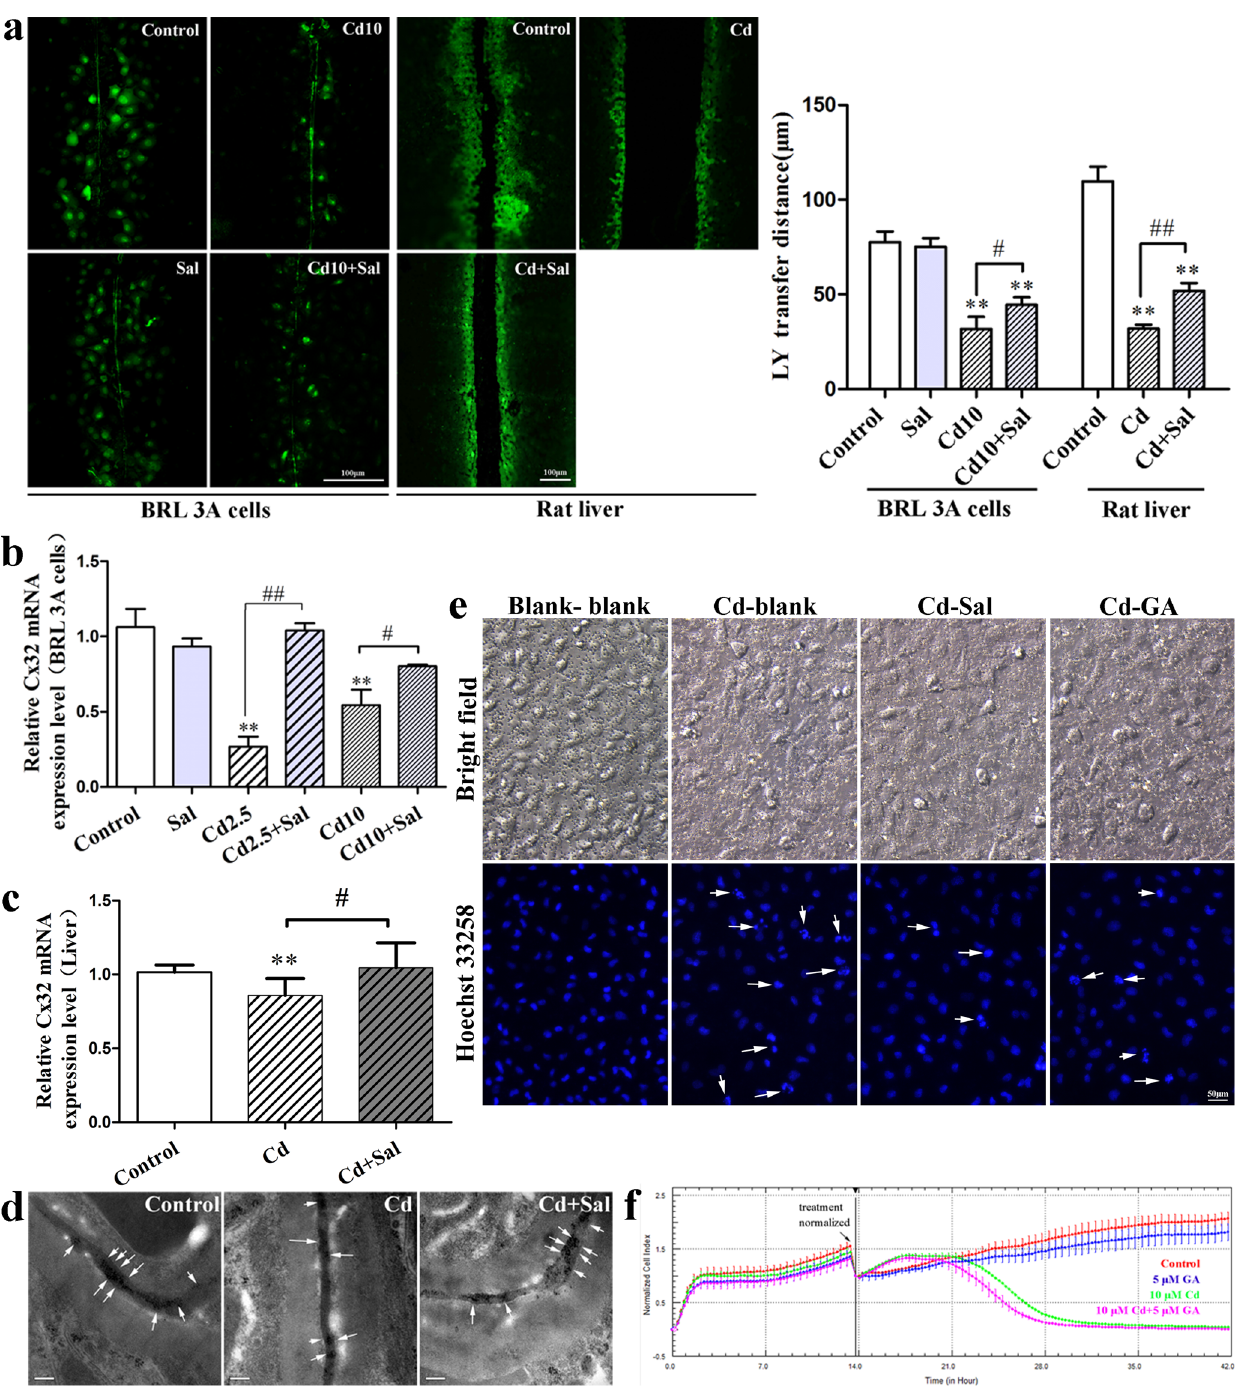
Fig 3. GJIC has a dual effect on Cd-induced cytotoxic injury. a : Effect of Sal on the Cd-induced down-regulation of GJIC in BRL 3A cells and rat liver tissue(Cd 2.5 means 2.5 μ m Cd, Cd 10 means 10 μ m Cd). LY transferred to adjacent cells via open gap junctions. Scale bar = 100 μ m. The average distance of LY spread from the side of the scraped edge from six different sites in each sample was obtained for quantification; b , c : Effect of Sal on Cd-induced decreases in Cx32 mRNA(relative Cx32 mRNA expression in BRL 3A cells and rat liver tissue). Values are the means ± S.D. ** p < 0.01 compared with the control group, # p < 0.05, ## p < 0.01 compared with the group indicated. d : Effect of Sal on Cd-induced alterations in the distribution of Cx32 in rat hepatocytes. Gold particles indicating Cx32 were observed at closely apposed plasma membranes of the hepatocytes, as shown by the arrows. Gold particle size = 5 nm. Scale bar = 0.2 μ m. e : BRL 3A cells influenced by Cd-exposed cells in a Transwell culture system. Cells were divided between the two sides of the insert according to their treatment. Scale bar = 50 μ m. f : Effect of 5 μ M GA on 10 μ M Cd-induced cytotoxicity in BRL 3A